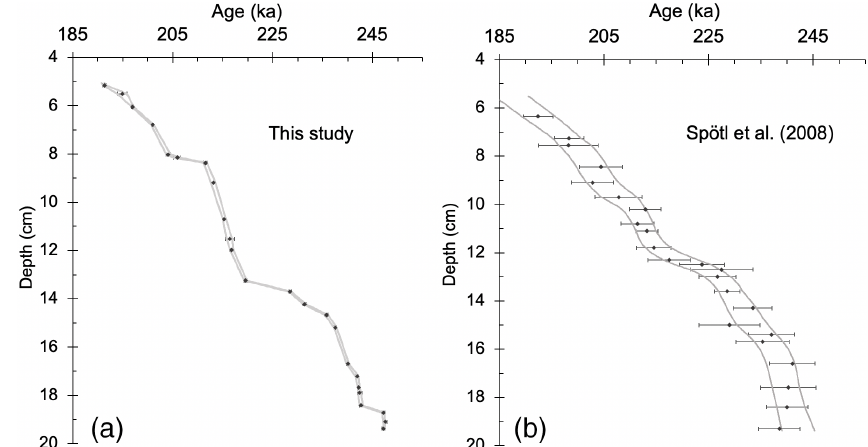
Figure 2. Depth vs. age along the growth axis of stalagmite SPA121 with associated 2 σ age uncertainties from this study (a) and Spötl et al. (2008) (b) . Gray lines show upper and lower 2 σ uncertainties of each age